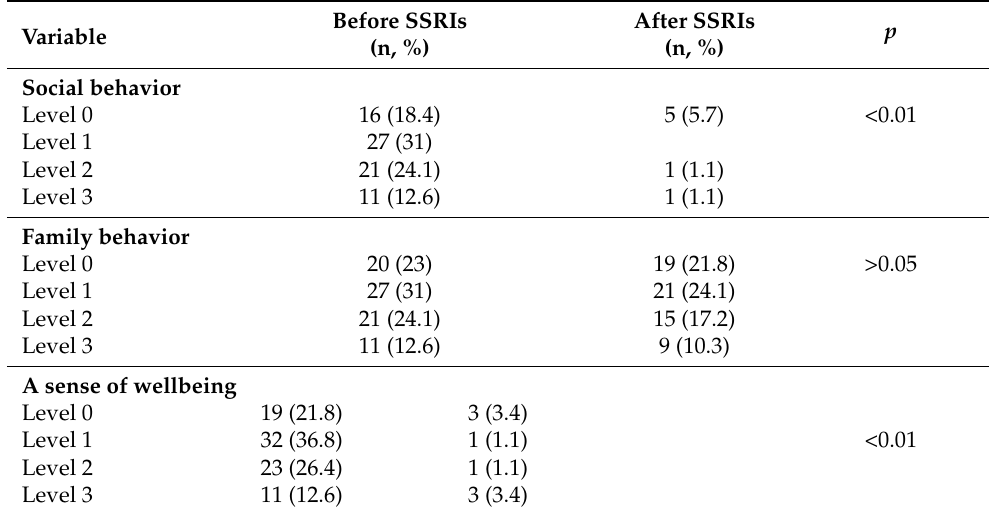
Table A1. Characteristics of psychophysical and social functioning (bad) according to mMRC before and after the use of SSRIs.